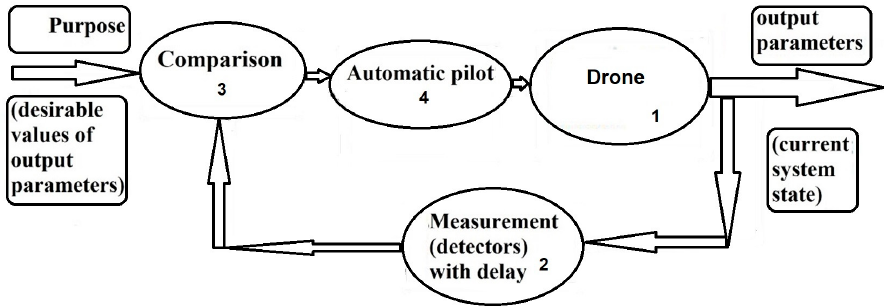
Figure 10. Automatic control: flying drones have output parameters (output of block 1) describing their position, orientation, and velocity. These parameters are measured and calculated by a measurement system with some time delay (output of block 2). These measured parameters and their desirable values, calculated from the steady-state trajectory (inputs of block 3), can be compared, and deviation from steady-state solution can be calculated (output of block 3). Automatic pilot gets these deviations and calculates control parameters for the drone to decrease these deviations. Then, the drone changes its output parameters (output of block 1). This cycle repeats at all times of the flight.